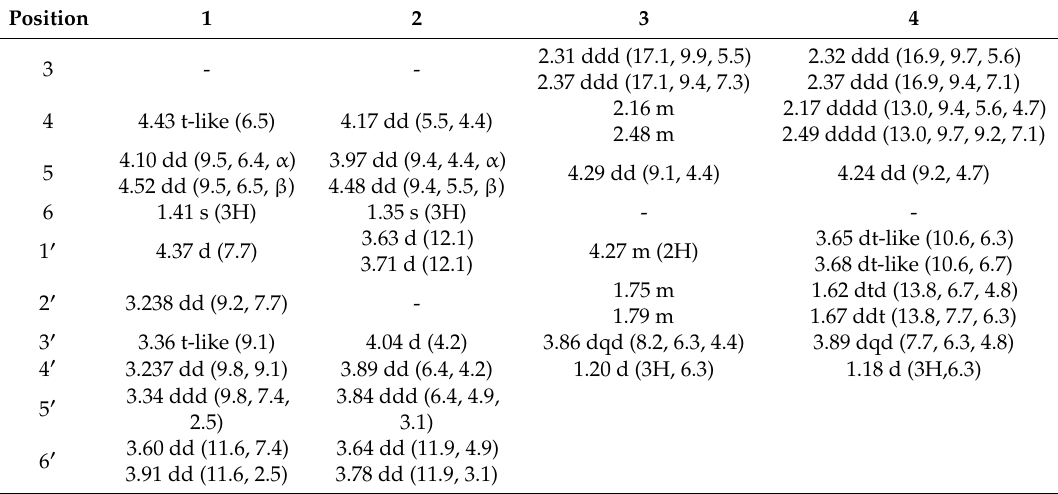
Table 1. 1 H-NMR spectroscopic data for compounds 1 – 4